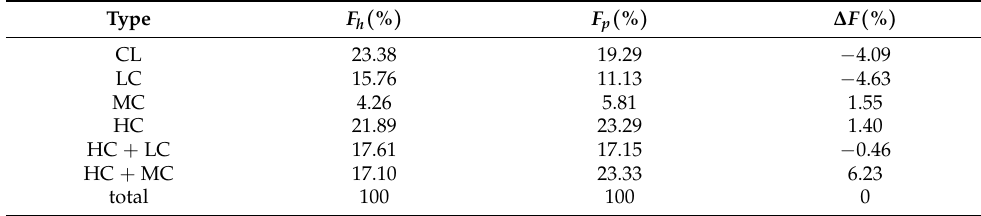
Table 6. Occurrence rate (%) of cloud type in